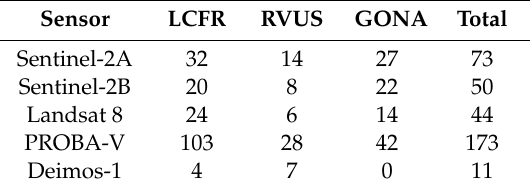
Table 2. Number of cloud-free matchups for the various sensors over the RadCalNet